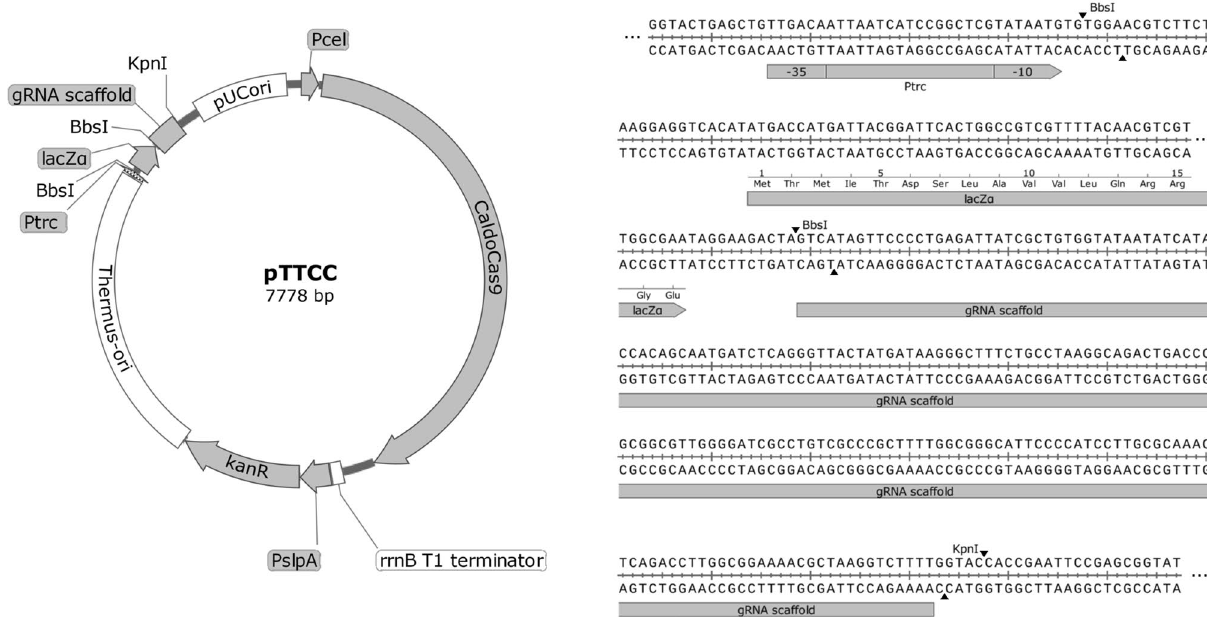
Figure 3. Composition of pTTCC, a CaldoCas9 genome editing system delivery vector. Left: a plasmid map illustrating the composition of pTTCC. The vector contains a gene encoding CaldoCas9 regulated by a cellobiose inducible promoter, P cel , and a transcription terminator; a gene encoding a thermostable enzyme conferring kanamycin resistance under regulation of a constitutive promoter P slpA ; T. Thermophilus and E.